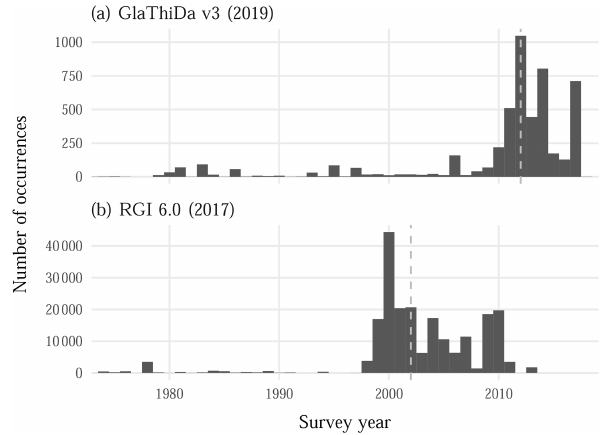
Figure 10. Comparison of the distribution of survey years between GlaThiDa (a) and RGI (b) . Medians are marked with grey dashed lines. Only survey years since 1975 are